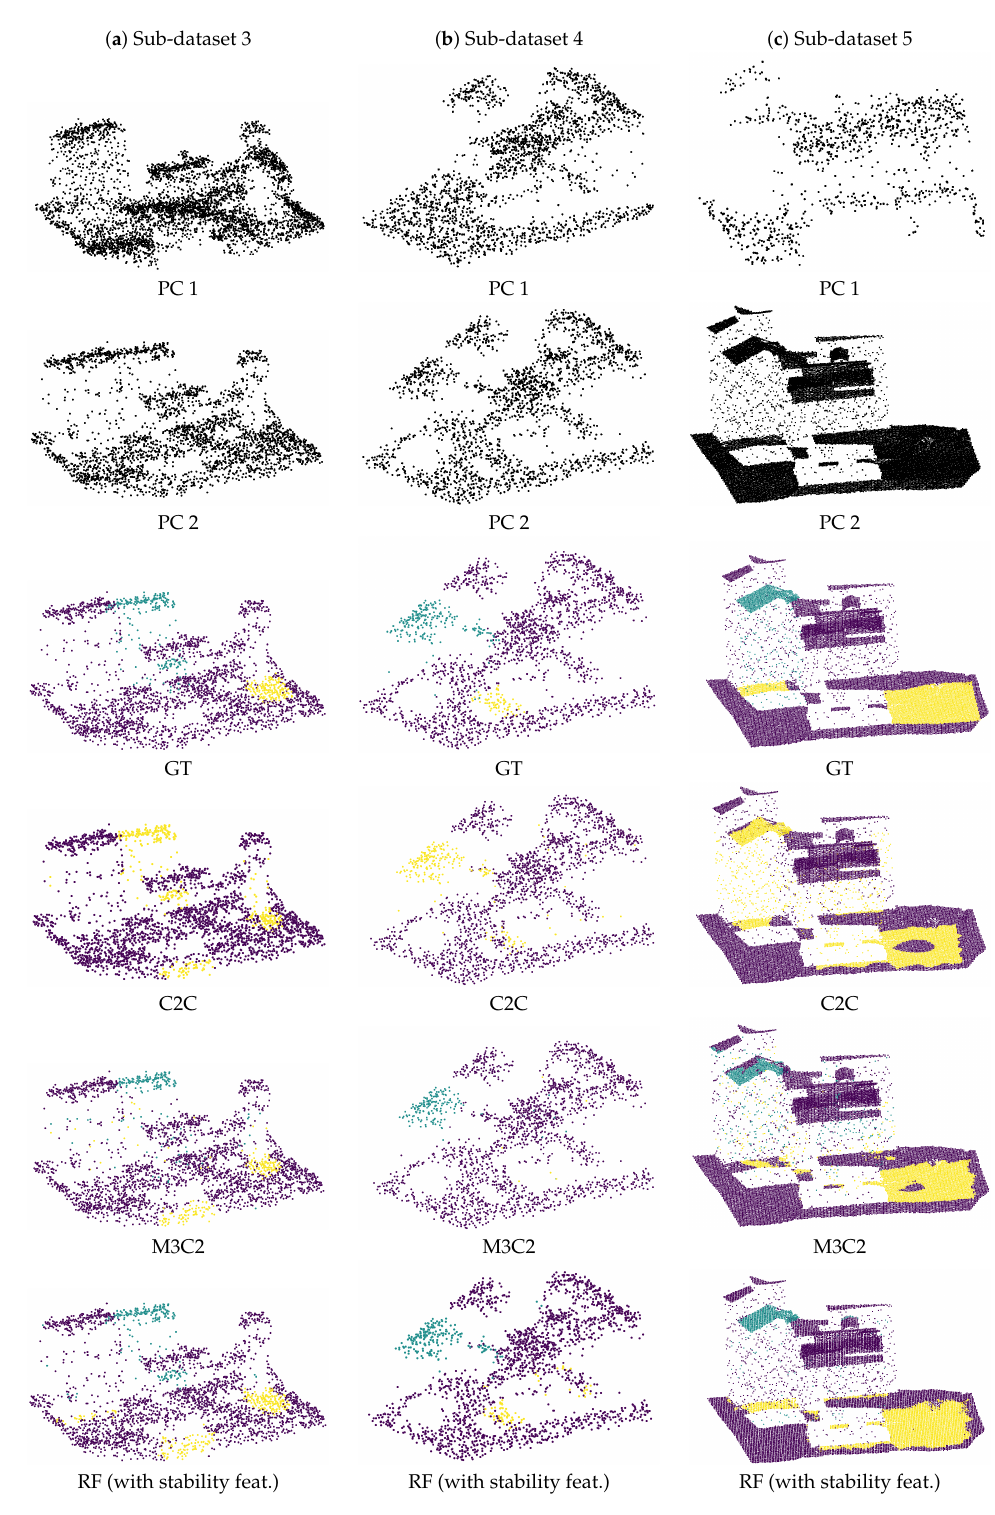
Figure 13. Results on PCs for methods at the 3D point level for sub-datasets 3 ( a ), 4 ( b ) and 5 ( c ). Both PCs corresponding to both dates are given. The corresponding ground truth (GT) indicates changes in the second PC (PC 2) compared to the previous PC (PC 1): purple for unchanged areas, blue for new construction areas and yellow for demolition areas. The same colors are used for M3C2 and RF with hand-crafted features. C2C results are only binary: purple corresponds to unchanged parts and yellow to changed